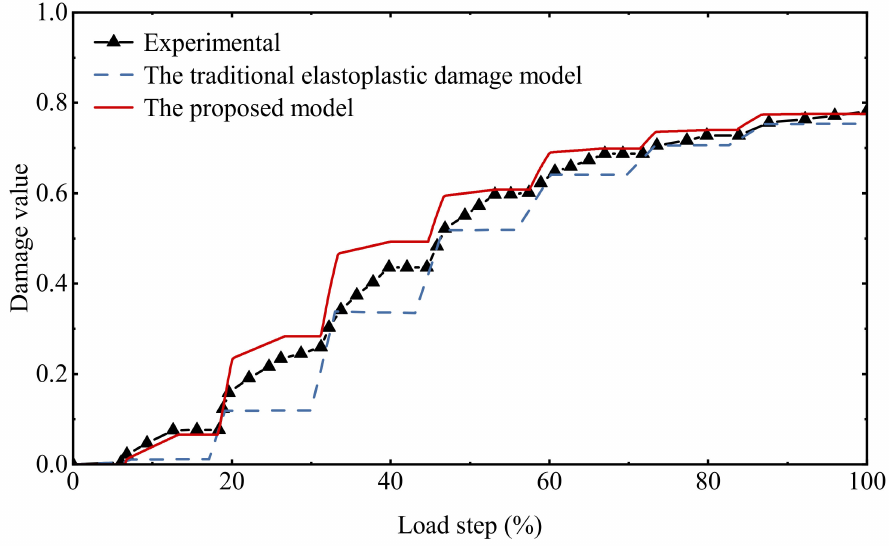
Figure 14. Comparison of damage history under uniaxial cyclic compressive